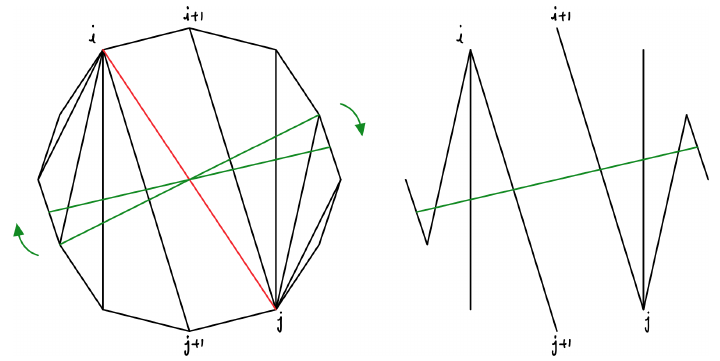
Figure 11 . A diagonal intersecting ( ij ) is not compatible with the dissection D ij